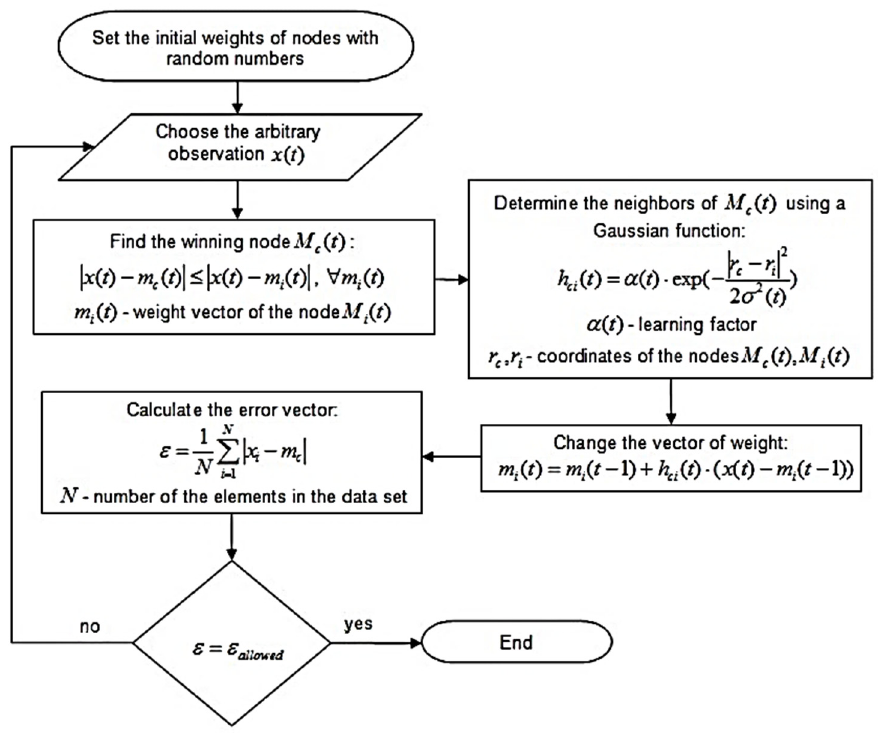
Figure 3. Kohonen self-organizing algorithm. Source: (Awrejcewicz et al. 2011). Training—network setting and results